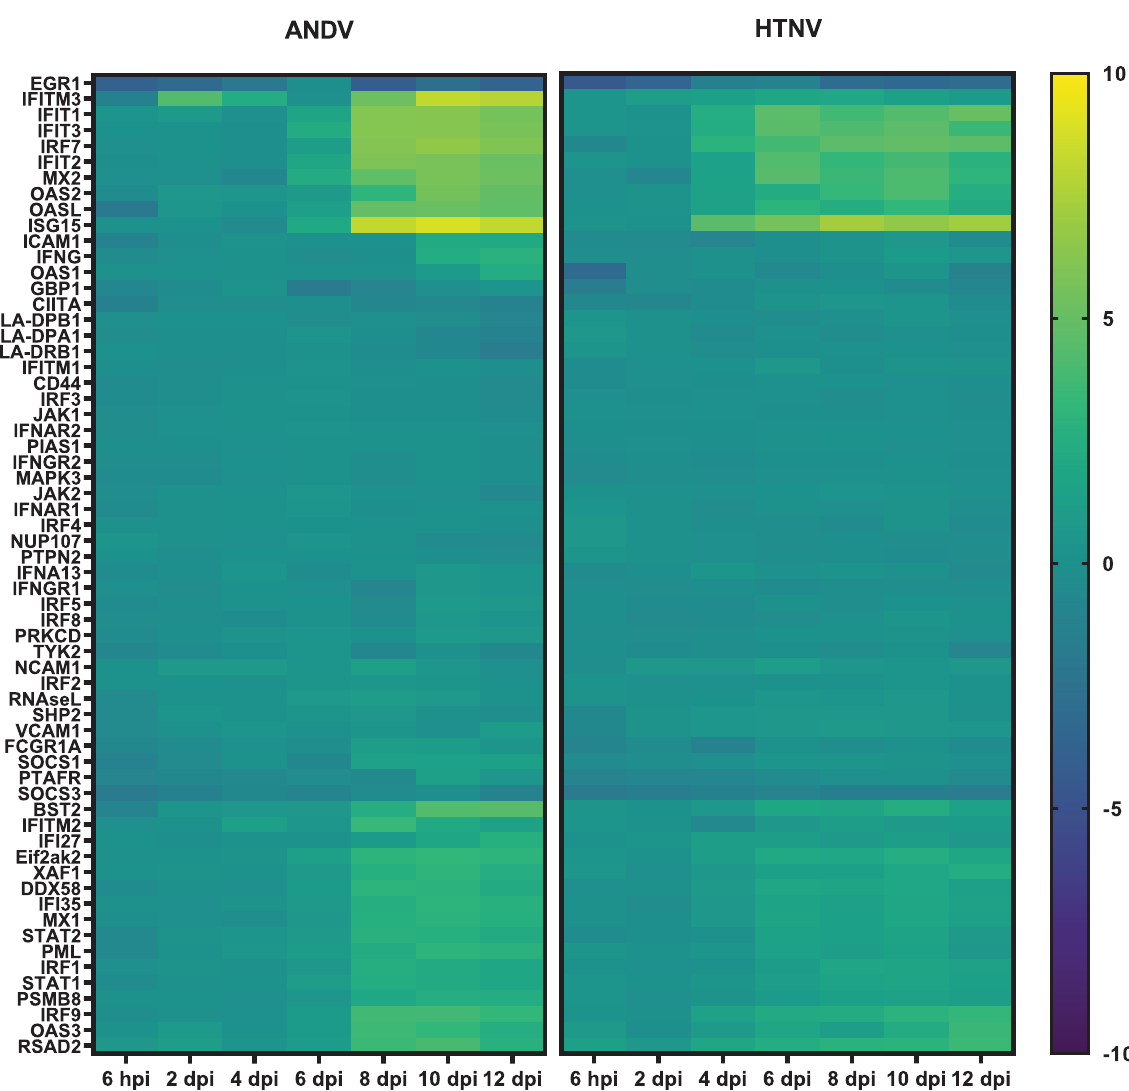
Fig 5. Interferon Signaling in Hantavirus Infected Hamsters. Genes associated with interferon signaling are displayed as a heat map with hierarchical clustering and intensity of the colors corresponding to the magnitude of fold change over the